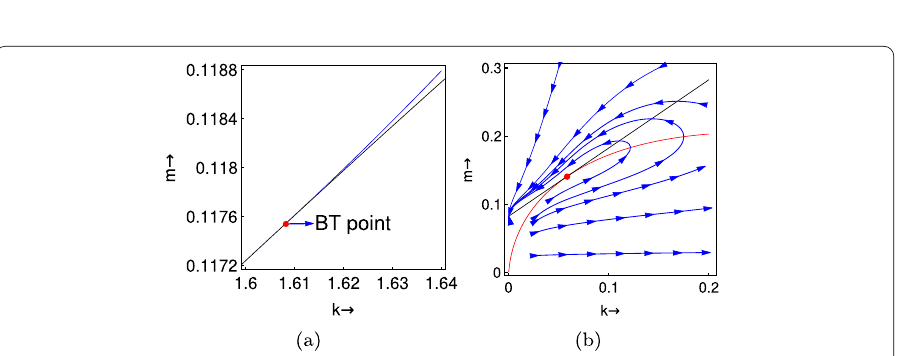
Figure 8 ( a ) Local amplification of Fig. 3 around BT point. ( b ) Phase portrait for system (2.4a)–(2.4b) around BT point